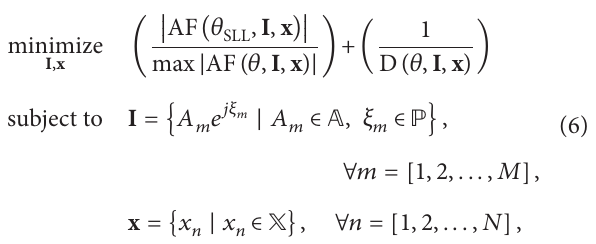
nonconvex optimization problems [13]. The optimization method to obtain near-optimal solutions is described